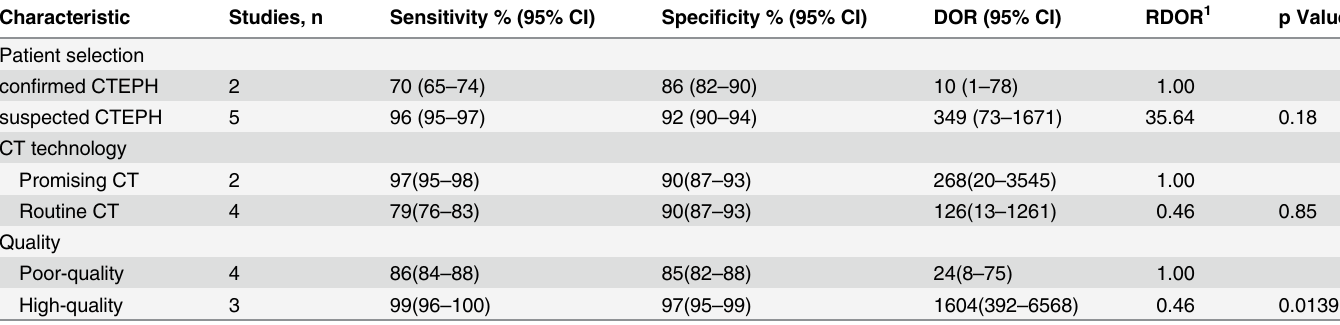
Table 3. Subgroup analyses for the diagnostic performance of CT on overall arterials level c